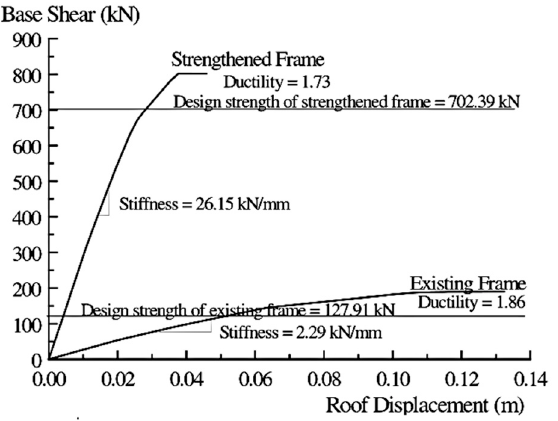
Figure 9. Comparison of the original frame and reinforced frame.